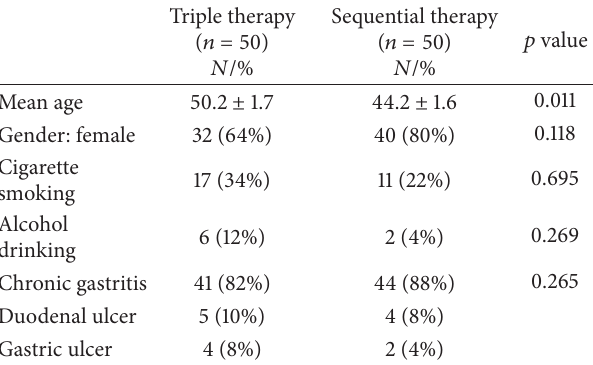
Table 1: Demographic and clinical characteristic of the